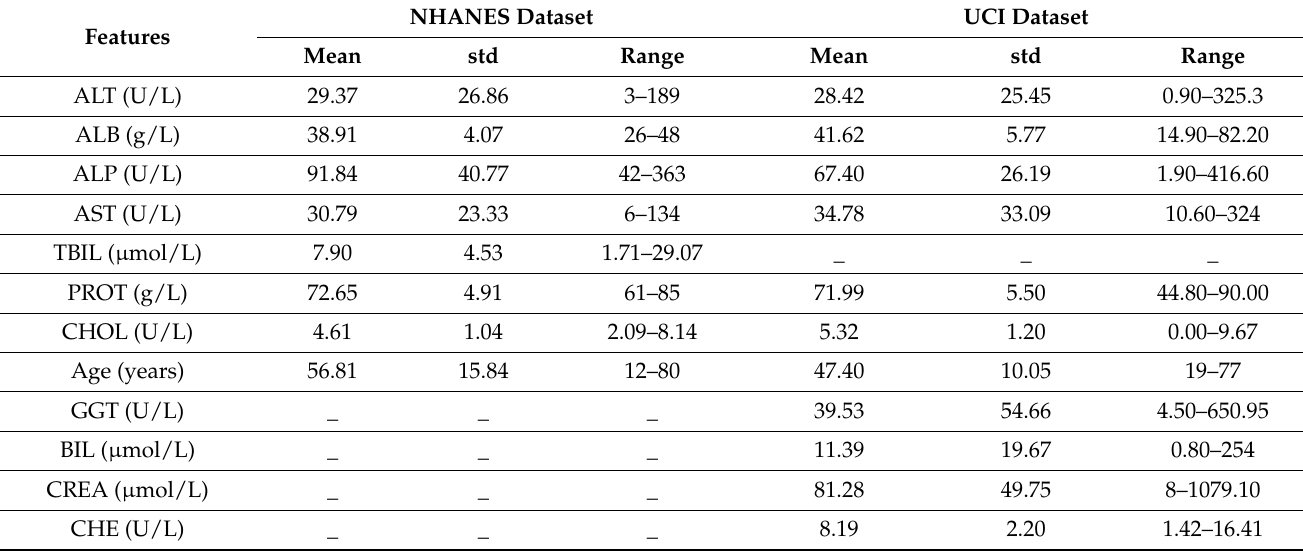
Table 1. Description of features of the datasets.